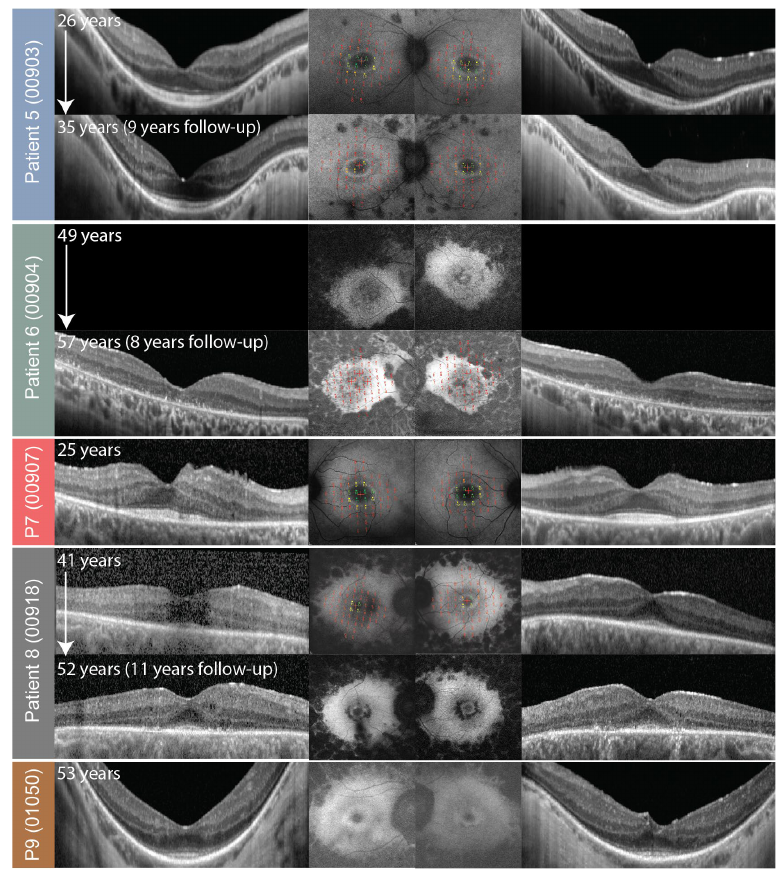
Figure 6. OCT (side columns) and FAF with overlaid microperimetry (central two columns) of patients 5–9. The right eye is shown on the left and the left eye on the right. Patient ID (center ID) is stated on the left side. Follow-up images are shown if available. Microperimetry images are enlarged in Figures 7 and 8.